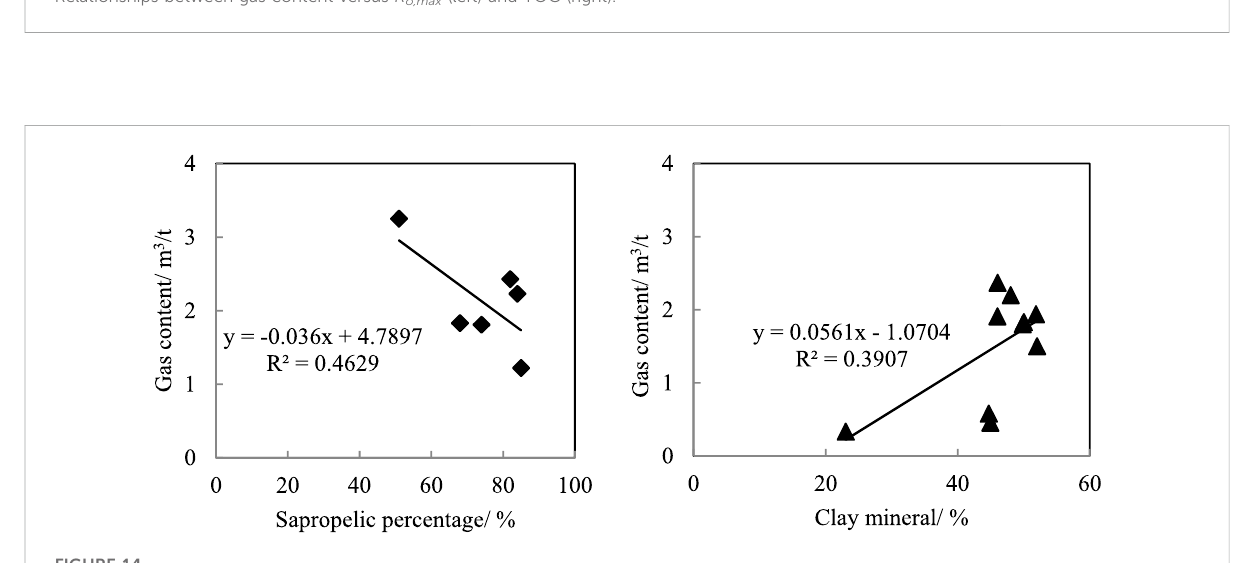
Frontiers in Earth